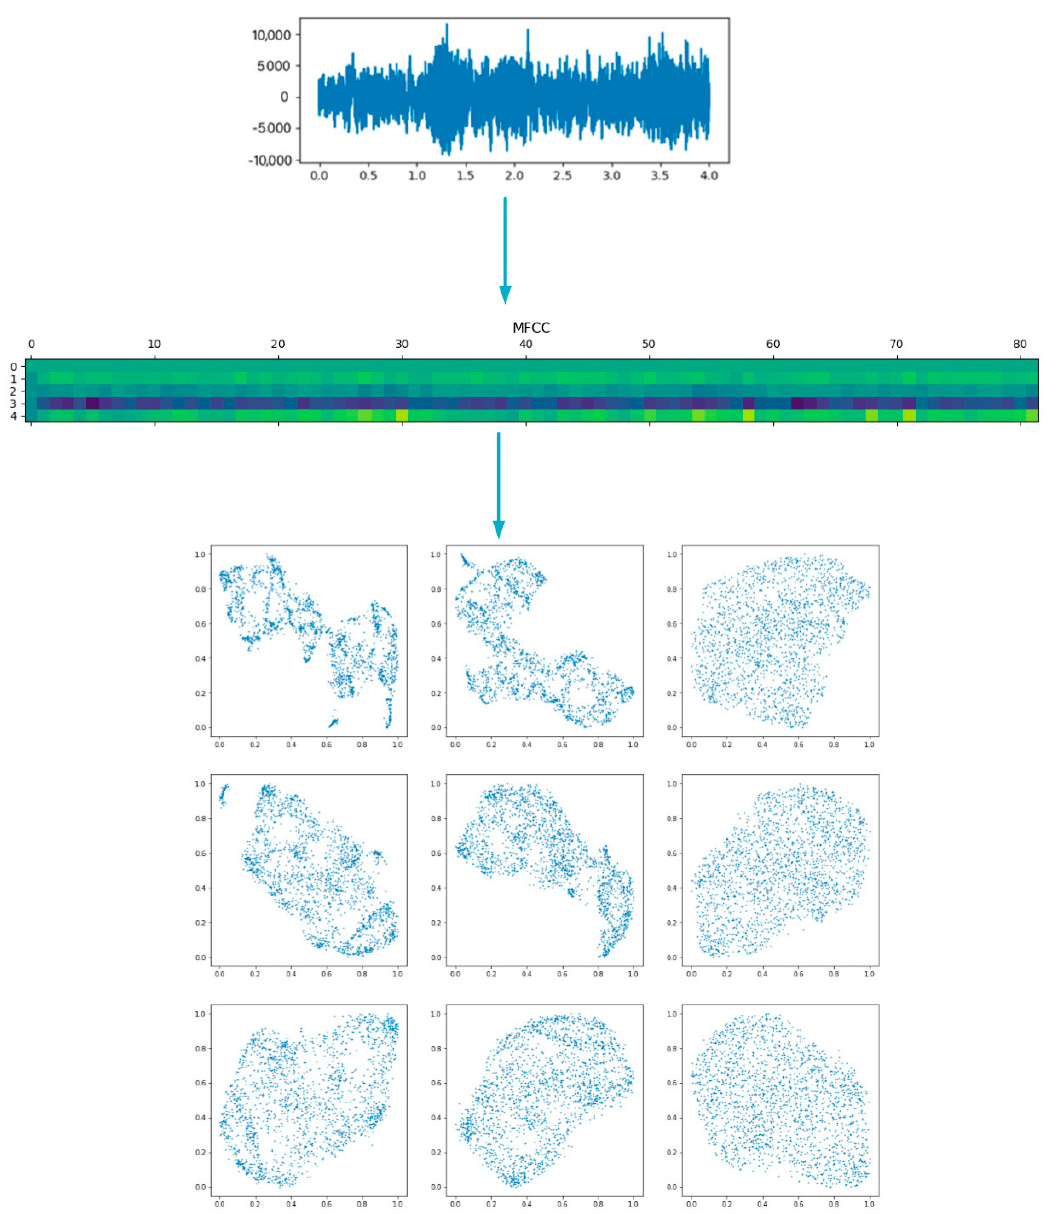
Figure 2. Feature extraction process based on T-SNE algorithm.